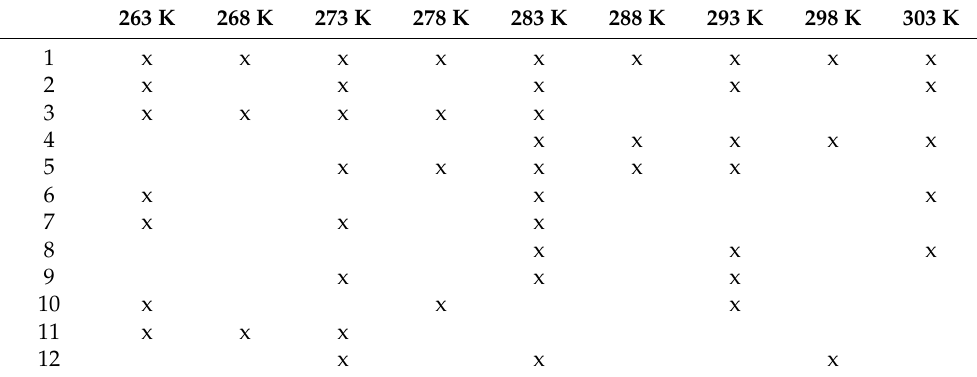
Table 2. Arrangements selected in the range from 263 K to 303 K.